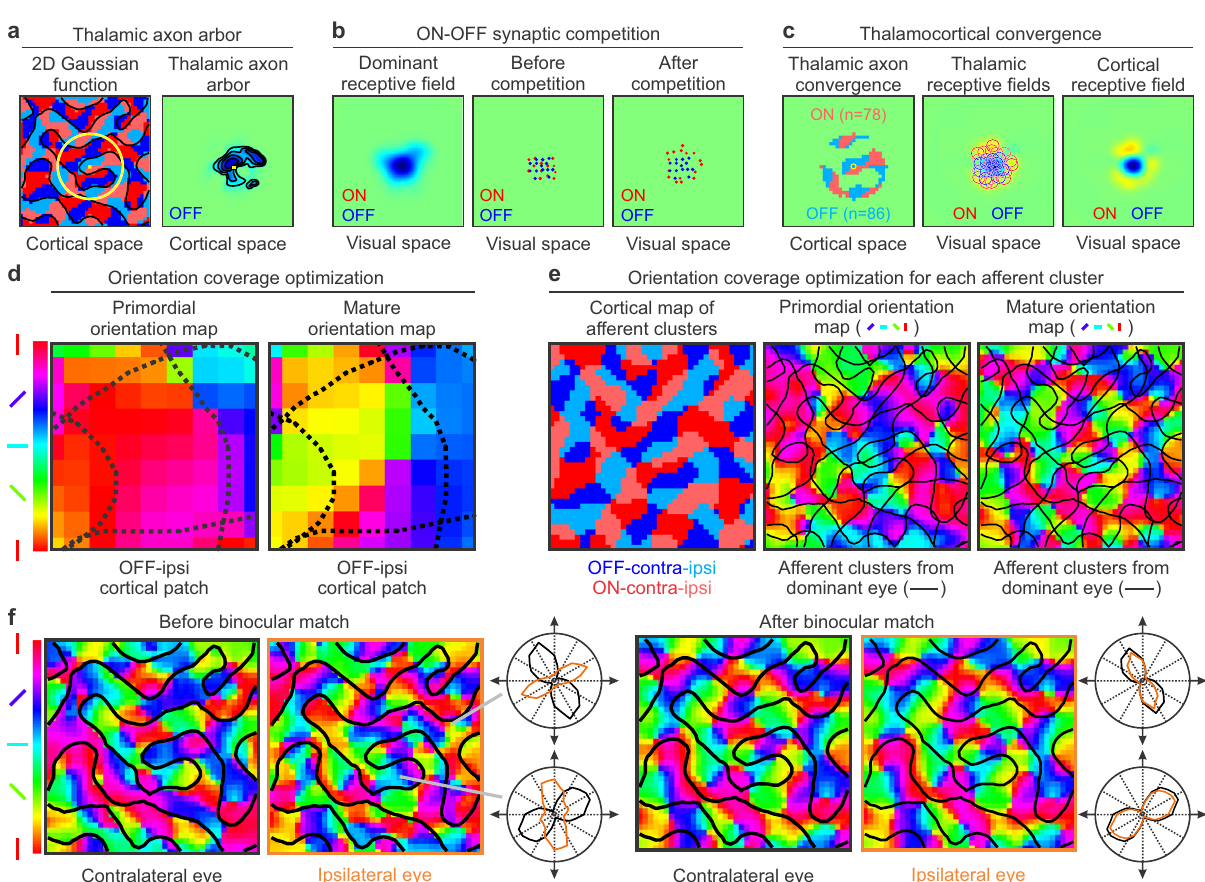
Fig. 5 Third model stage. Development of visual cortex. a After the afferent sorting is complete, the model simulates the spread of each afferent axon arbor with a Gaussian function (left, yellow circle, standard deviation ~3 cortical pixels, radius: 10 cortical pixels). The synaptic weight of the axon arbor is maximum at the center of the Gaussian (small yellow pixel) and zero at the Gaussian borders. The fi nal size of the axon arbor (right) is also shaped by synaptic competition. b The synaptic competition changes the synaptic weights of the afferents with non-dominant polarity converging at each cortical pixel. The synaptic change is based on the overlap between the afferent receptive fi eld and the dominant receptive fi eld of the cortical pixel (left). The synaptic weight decreases when the overlap is large and increases when it is small, as illustrated in the fi gure for afferents with synaptic strength >50% of maximum (middle and right). The dot location illustrates the receptive fi eld position in visual space and the dot size illustrates the synaptic strength. c Afferents converging at the same cortical pixel segregate in cortical space (left, cortical position of main axon trunks), and visual space (afferent receptive fi elds). The cortical receptive fi eld is calculated as the weighted receptive fi eld average of the afferents (right). d The model optimizes the orientation coverage at each afferent cluster, as illustrated for an example OFF-ipsi afferent cluster (left, demarcated by dotted lines). This afferent cluster is strongly biased towards horizontal orientations (red pixels) in the primordial map but its orientation coverage becomes more uniform in the mature map (right, notice the greater diversity in pixel colors). e The model maximizes the orientation coverage for each afferent cluster (left) to transform the primordial orientation map (middle) into a mature map (right, afferent clusters demarcated by black lines). f The model also maximizes the binocular match of the orientation map by adjusting the synaptic weights of the afferents from the non-dominant eye (left) to match those of the dominant eye in the mature orientation map